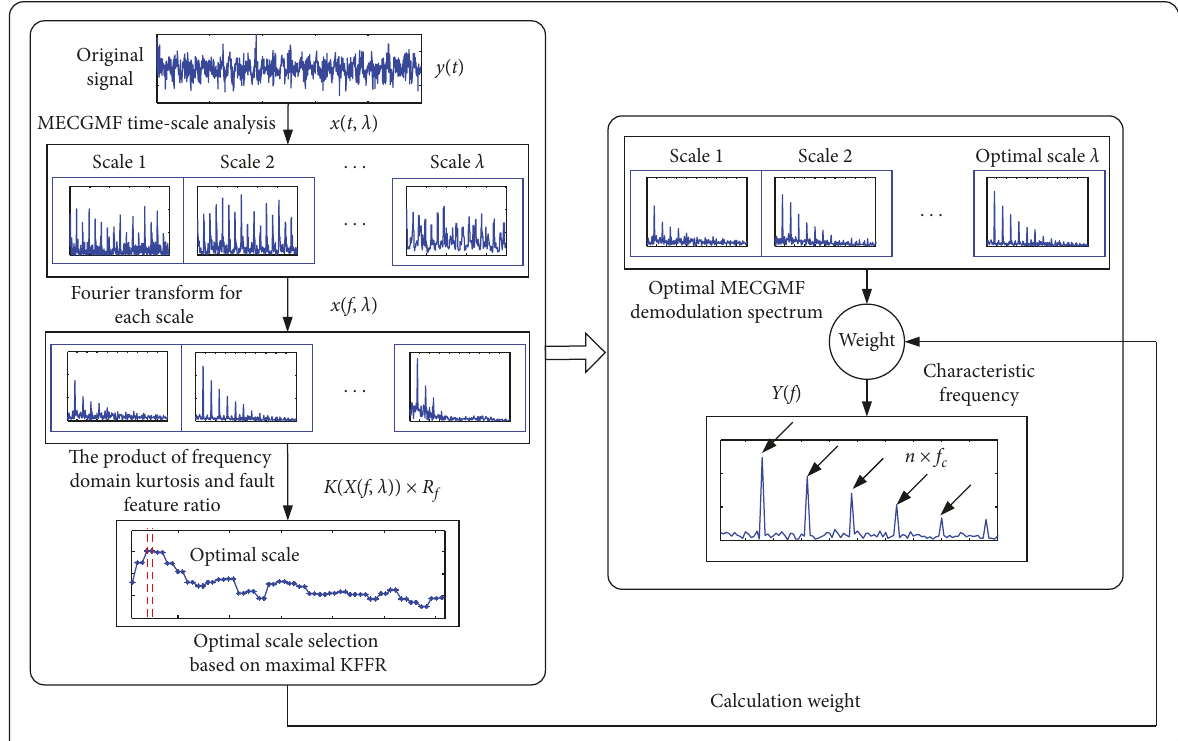
Figure 4: Flowchart of the proposed method for bearing defect detection.